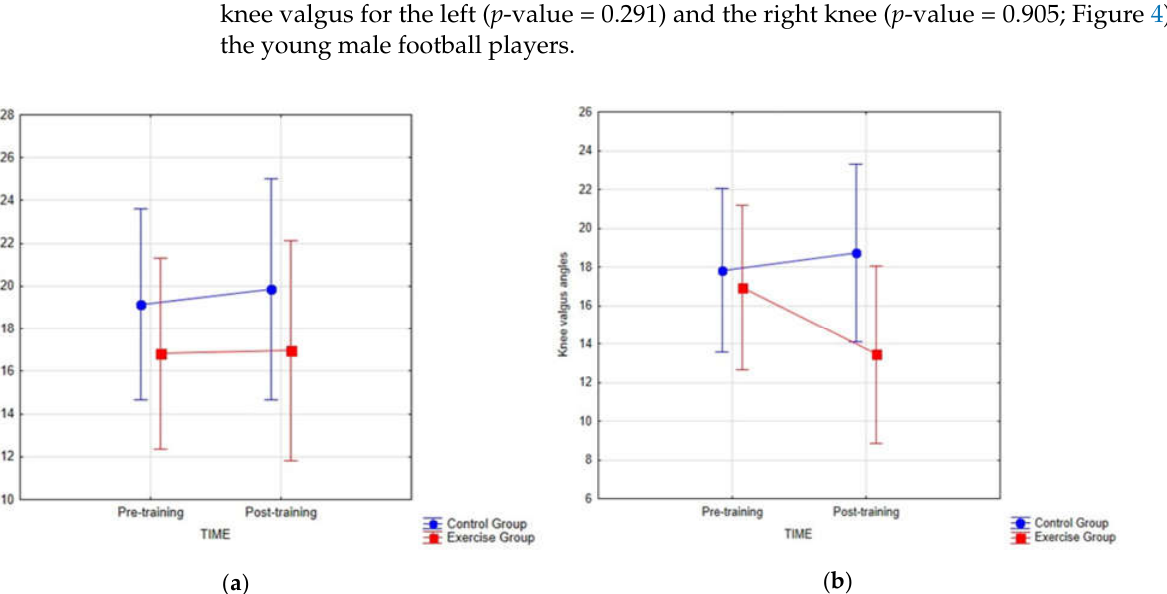
Table 3. Comparison within-group and between group for the dynamic knee valgus.